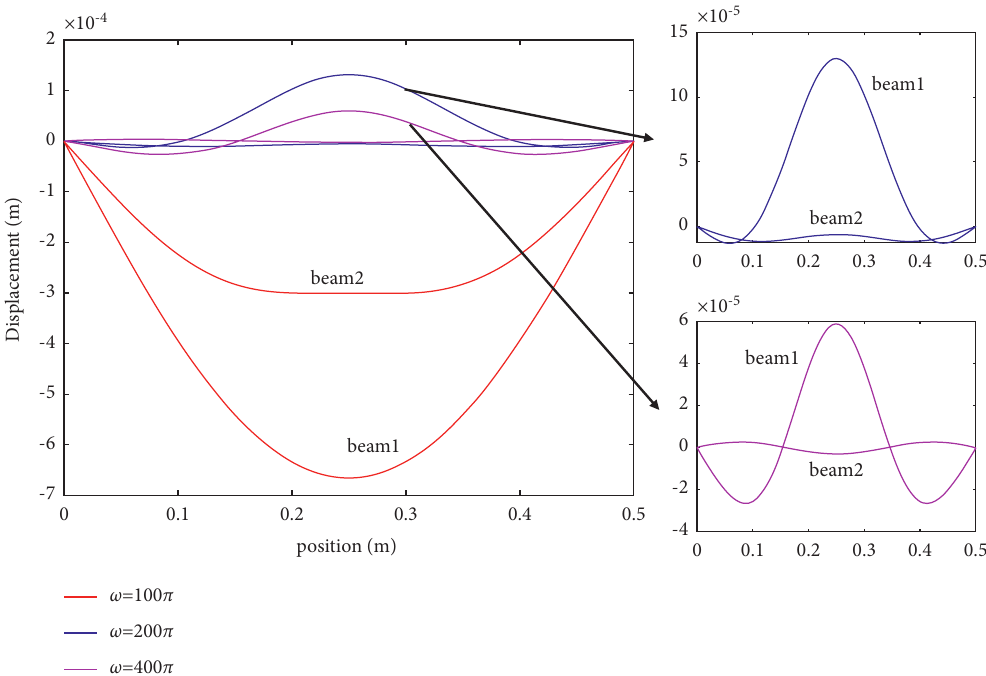
Figure 19: Vibration shape response excited by different